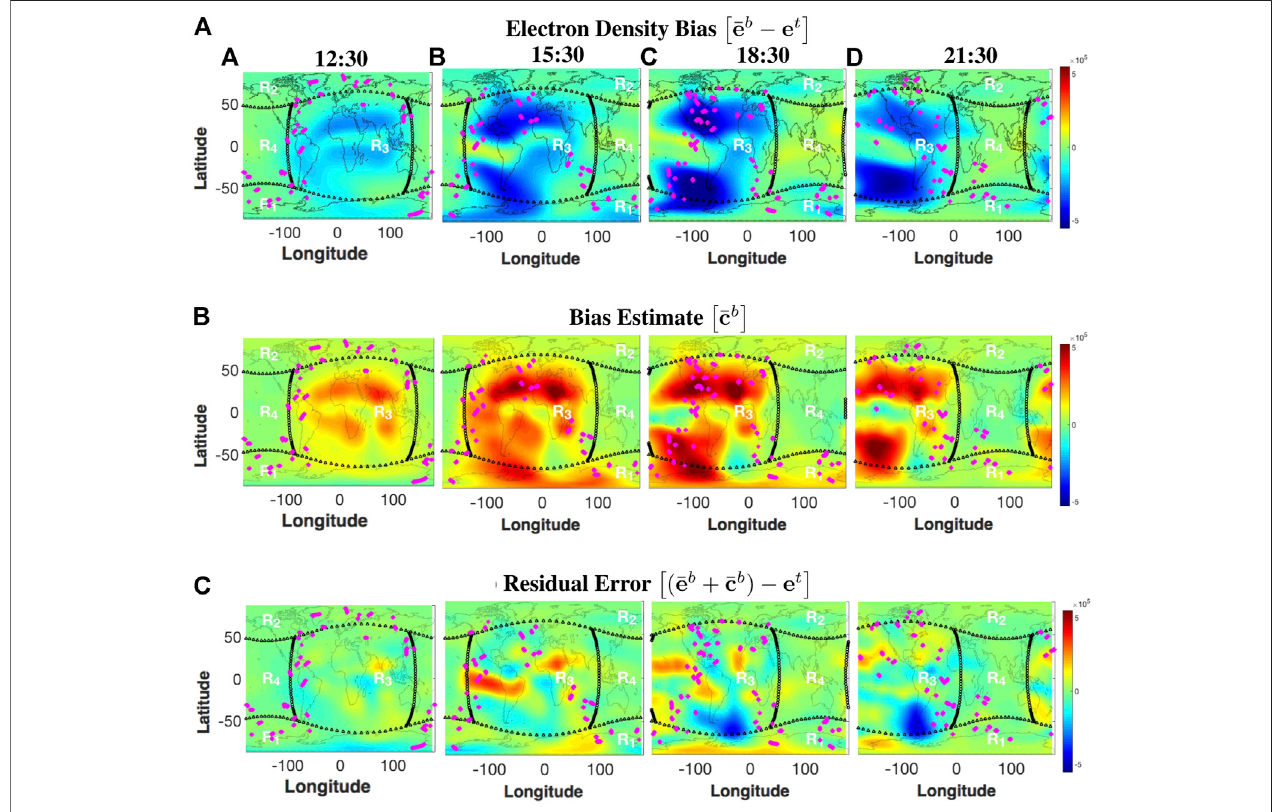
FIGURE7 |(A) Sameglobal maps ofelectron density bias asshown in Figure 2A . (B) Spatial structure ofthe biascorrectionestimates, c b L ,at thesame times and altitudes. (C) Analogous global maps of electron density bias after the fi eld of correction estimates is